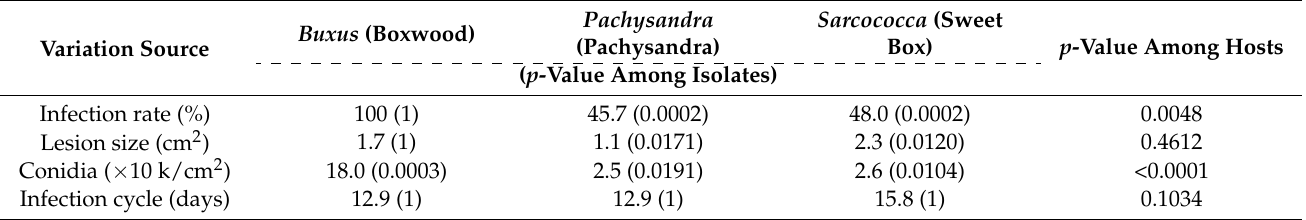
Table 2. Comparison of differential aggressiveness components during 10 passages of three Calonectria pseudonaviculata isolates on their plants of